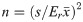
Minimum number of trees to be sampled using the mean number of new shoots.Optimal sample size (number of trees) to reach a relative sampling error of 25% [n=(s/Erx¯)2] [3] and mean number of shoots (±SEM) on each sample date for each sample size, considering the average number of shoots inside the 0.25 m2 frame [west side (A and B), east side (C and D), average data from both sides (E and F)].